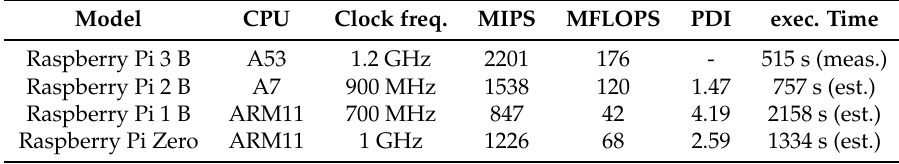
Table 4. Estimated performance comparison of different Raspberry Pi models.